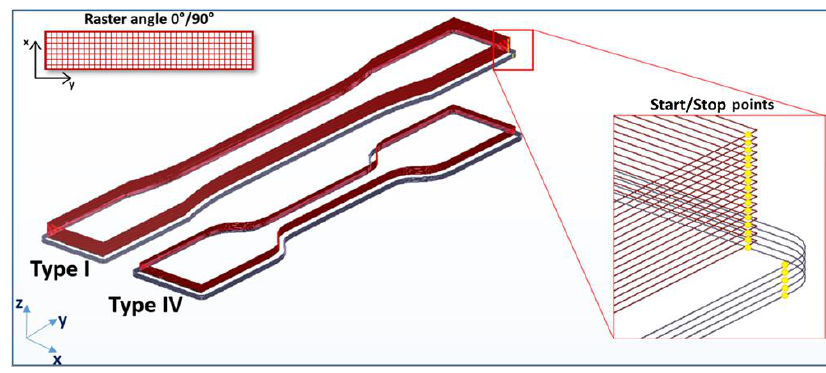
Figure 2. Slice and toolpath for tensile test specimens.